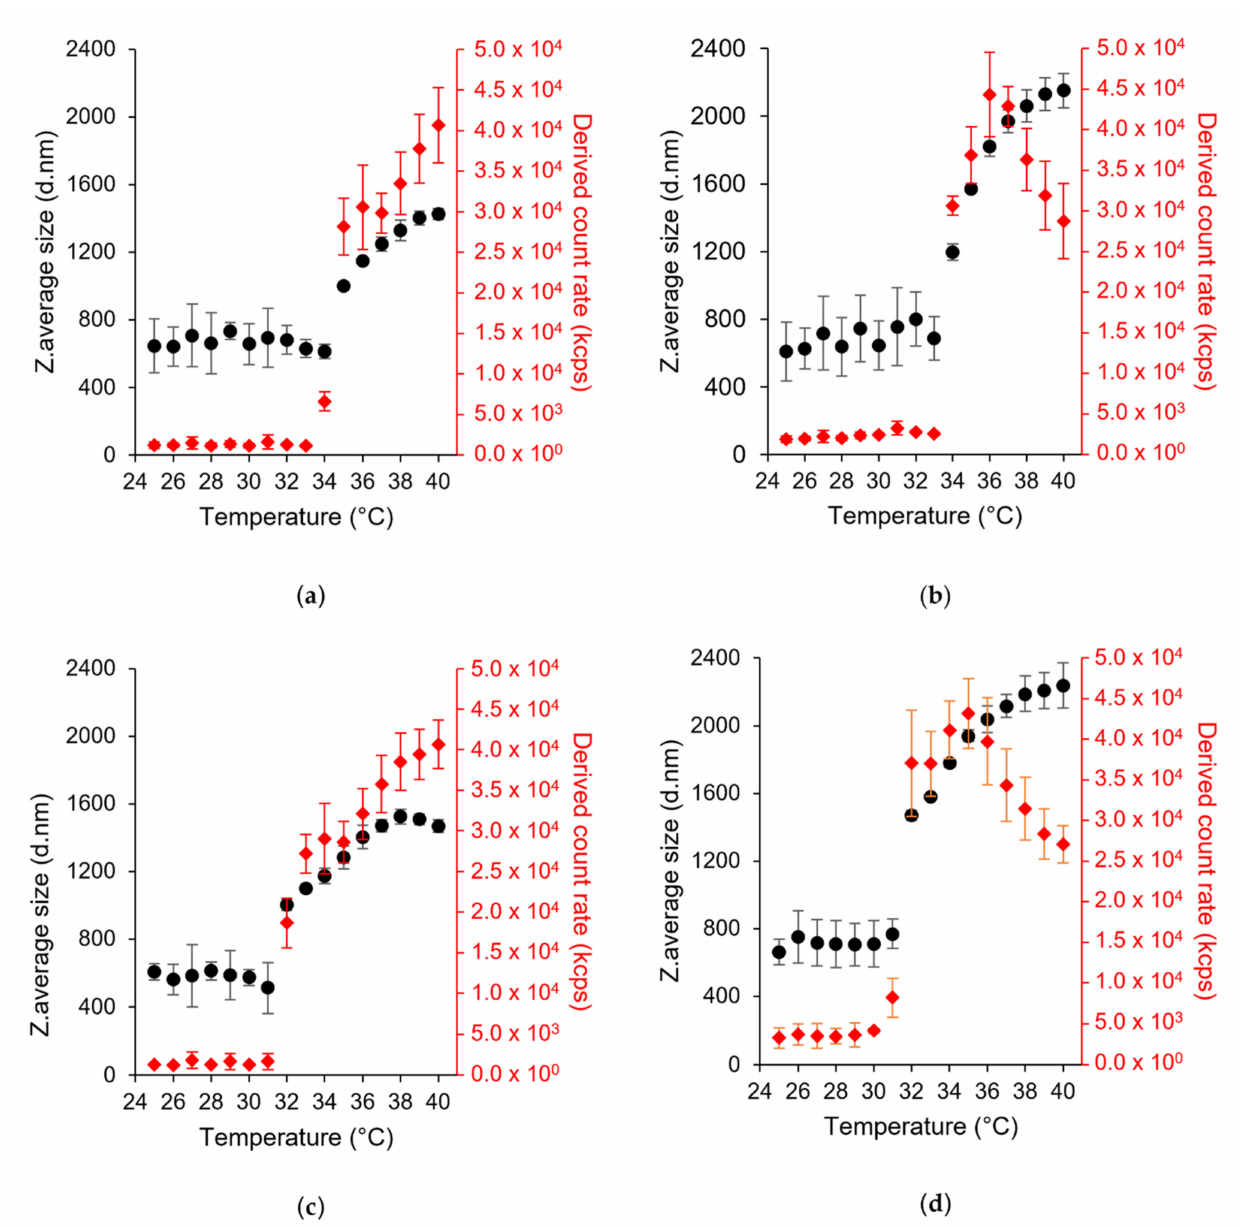
Figure 2. Particle size (left y-axis) and light scattering intensity (in kcps, kilo count per second) (right y-axis) as a function of temperature in DLS, ( a , b ) HA-pNIPAM 0.1 and HA-pNIPAM 0.25 when heating from 25 ◦ C to 40 ◦ C, ( c , d ) HA-pNIPAM 0.1 and HA-pNIPAM 0.25 when cooling from 40 ◦ C to 25 ◦ C, respectively (mean ± SD, n = 3). The first temperature point showing the significant change in the size of the nanogels indicates